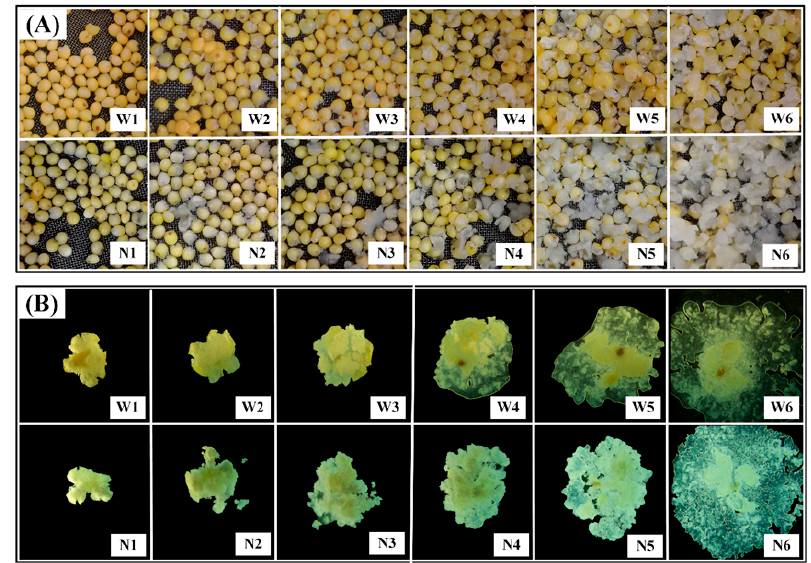
Figure 1. Morphology pictures of proso millet grains at di ff erent cooking times ( A ), and proso millet grains at di ff erent cooking times pressed between two glass slides during ( B ). W0–W6: uncooked, and cooked for 5, 10, 15, 20, 25, and 30 min, respectively; N0–N6: Uncooked and cooked for 5, 10, 15, 20, 25, and 30 min, respectively.